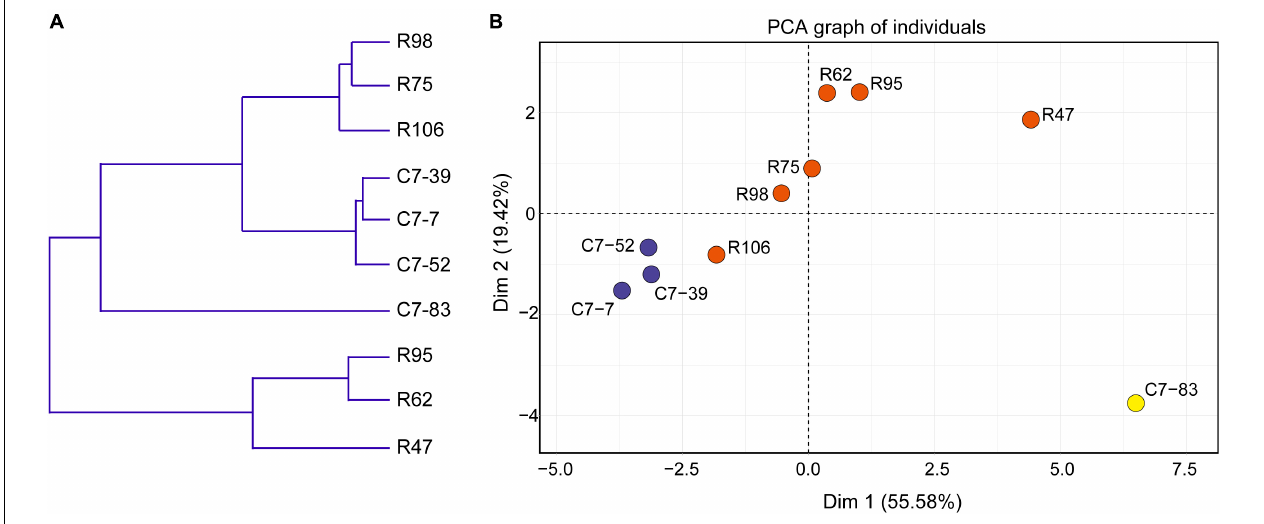
FIGURE 4 | (A) Dendrogram of nonhierarchical clustering analysis and (B) score plot of principal component analysis for the ten Lactiplantibacillus isolates based on probiotic physiological data. Axis 1 and 2 accounted for 55.6% and 19.4% of the total variation present,